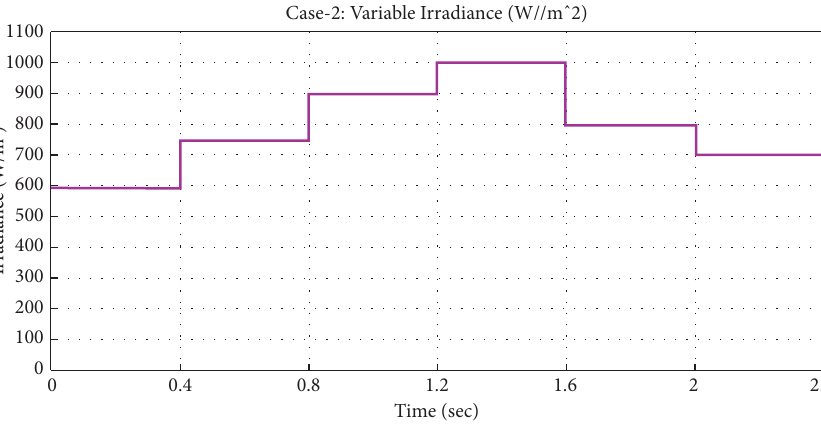
Figure 16: Input solar irradiation in Case